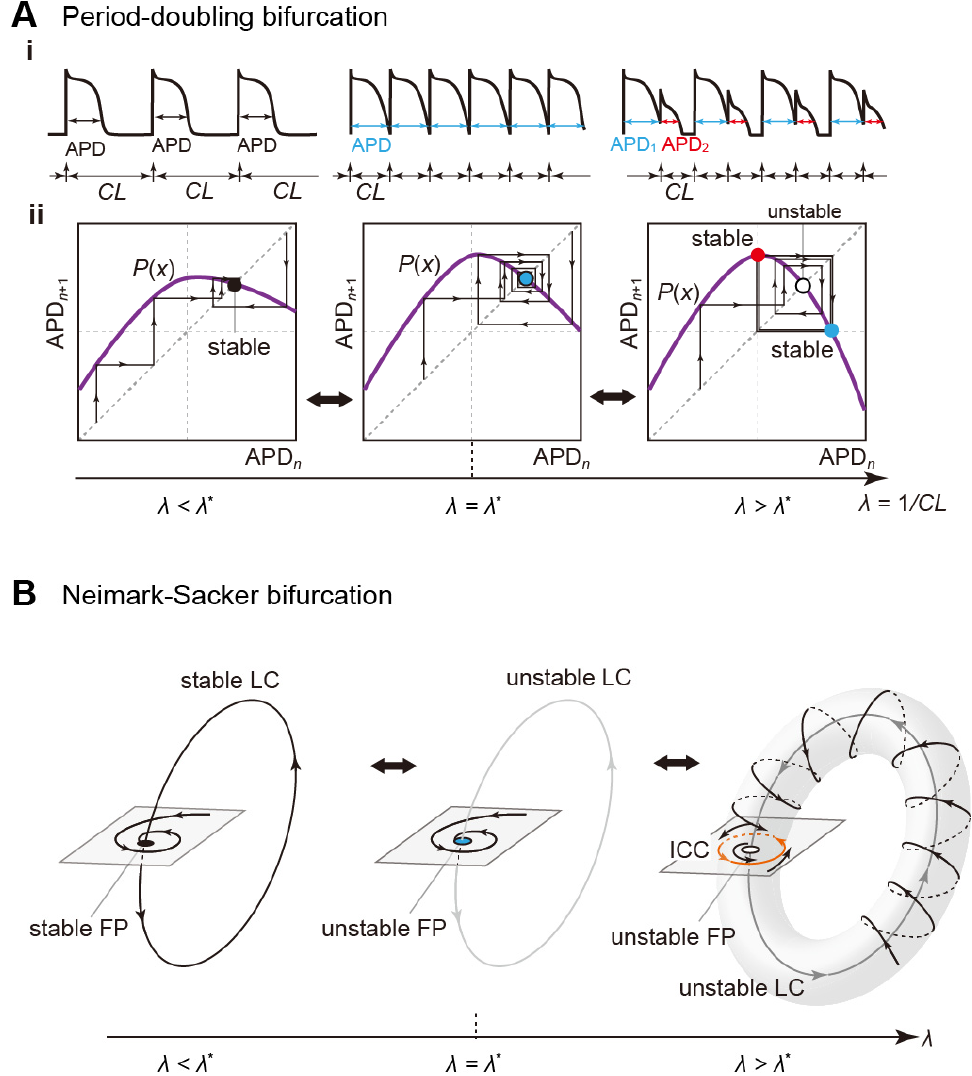
Figure 9. Schematic diagrams of period-doubling and Neimark–Sacker bifurcations. ( A ): A typical example of the period-doubling (PD) bifurcation in non-autonomous systems is AP alternans ( i ). As the cycle length ( CL ) becomes shorter, the stable fixed point on the (APD n , APD n +1 )-plane becomes unstable at the period-doubling bifurcation point ( λ *), and a pair of periodic points is generated ( ii ). ( B ): The change in a limit-cycle (LC) oscillation through the Neimark–Sacker (NS) bifurcation in autonomous systems. The NS bifurcation occurs at λ * as the parameter λ changes. Then, the LC oscillation becomes unstable and a torus-like oscillatory response, so-called “quasi-periodic oscilla- tion”, occurs around the unstable LC oscillation. When the quasi-periodic oscillation is discretized as a point sequence via the Poincaré mapping, a closed curve, which is referred to as an “invariant closed curve (ICC)”, appears around the unstable fixed point that reflects the unstable LC oscilla- tion.